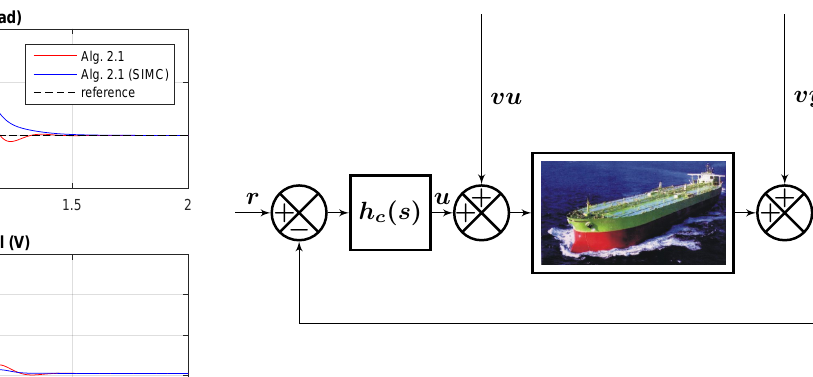
Figure 16: Example 3.9. Feedback system. Vessel